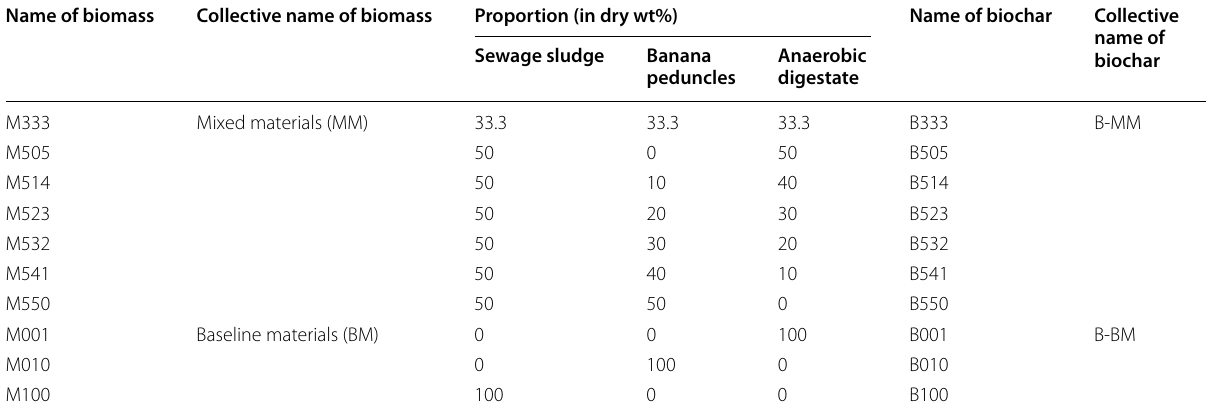
Table 1 List of substrates – mixed and baseline materials – used for co-pyrolysis, and the names of the biochar derived from these